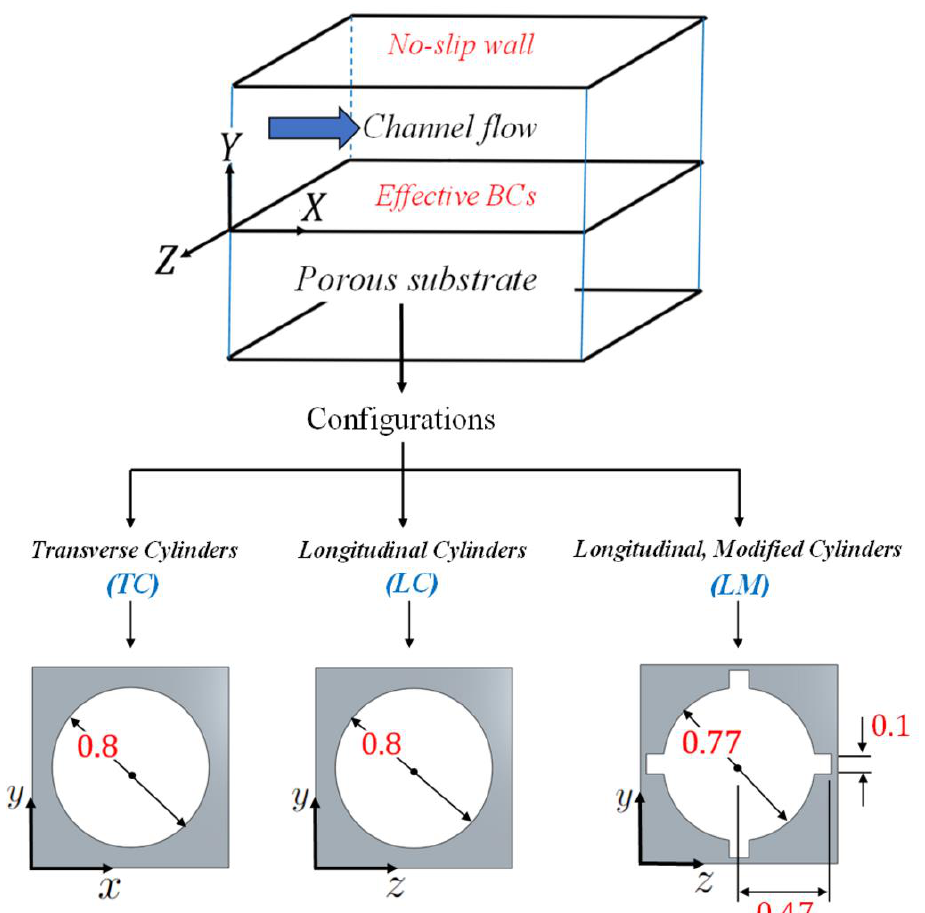
Figure 11. Sketch of the macroscale problems. The computational domain is displayed in the top panel, with the effective velocity boundary conditions imposed at the plane Y = 0. The usage of the effective conditions permits to not solve for the flow in the porous substrate. In the bottom frame, the configurations of the porous media under study are indicated, with the dimensions shown on a 1 × 1 unit cell. The dimensions of the inclusions yield a porosity θ =